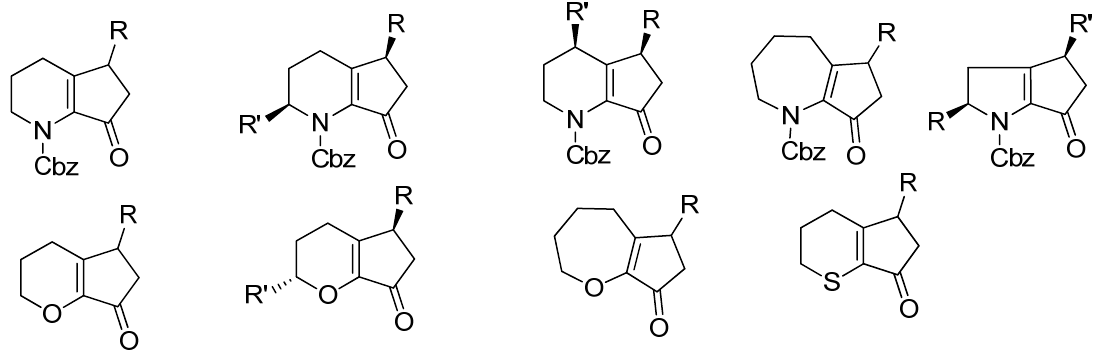
Figure 3. Representation of some of the scaffolds that can be synthesized through SM coupling between heterocyles derived triflates or phosphates and alkoxydienyl boronates.